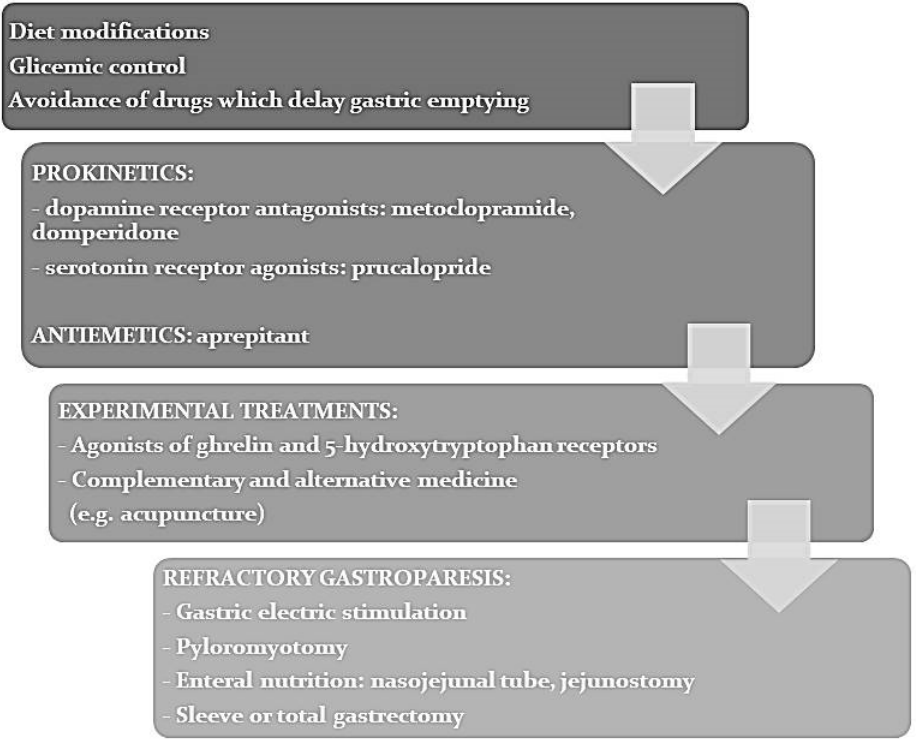
Figure 2. Treatment algorithm for diabetic gastroparesis.